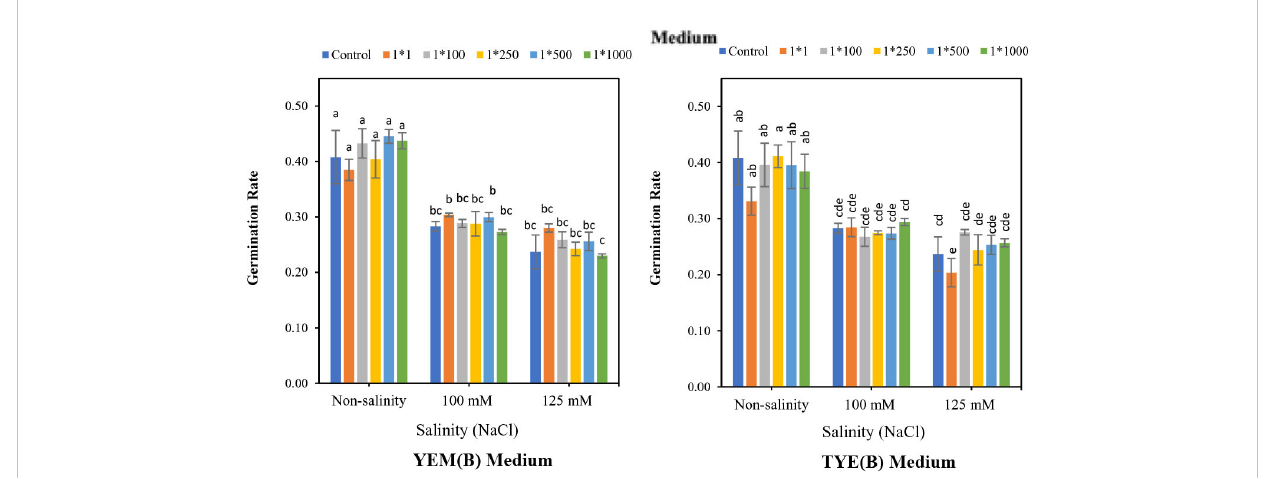
FIGURE 5 Effect of dilutions of Devosia sp. YEM(B)-CFS and TYE(B)-CFS and salinity on germination rate of soybean seedlings. Values represent the mean of four replicates ± SD. 1:1, 1:100, 1:250, 1:500 and 1:1000 = 1 mL Devosia sp. CFS and 1, 100, 250, 500, and 100 mL distilled water, respectively.